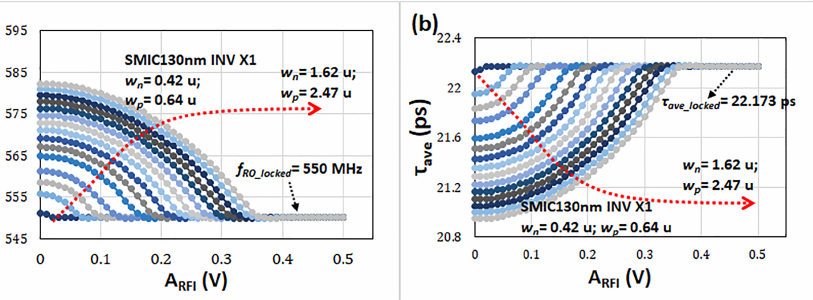
Figure 7. Synchronous locking verification of the 41-stage RO with process deviation. ( a ) Frequency- response curves; ( b ) average gate-delay-response